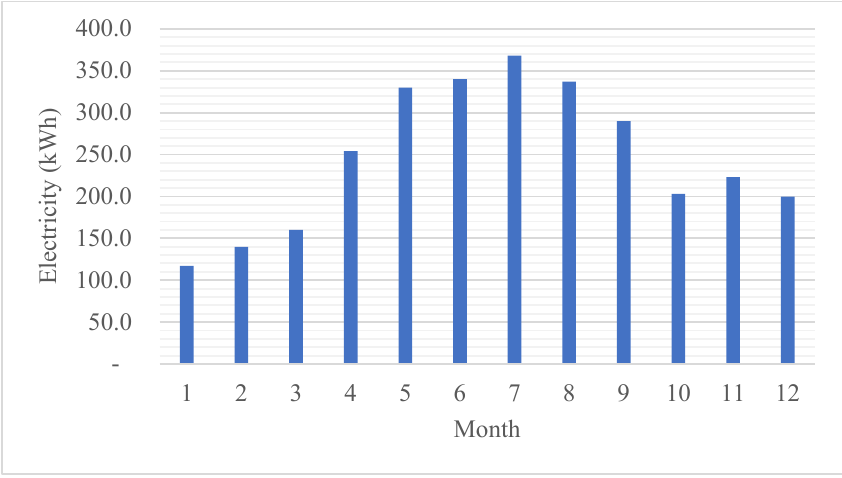
Figure 14. Power generation during the year of the solar power station at IES.